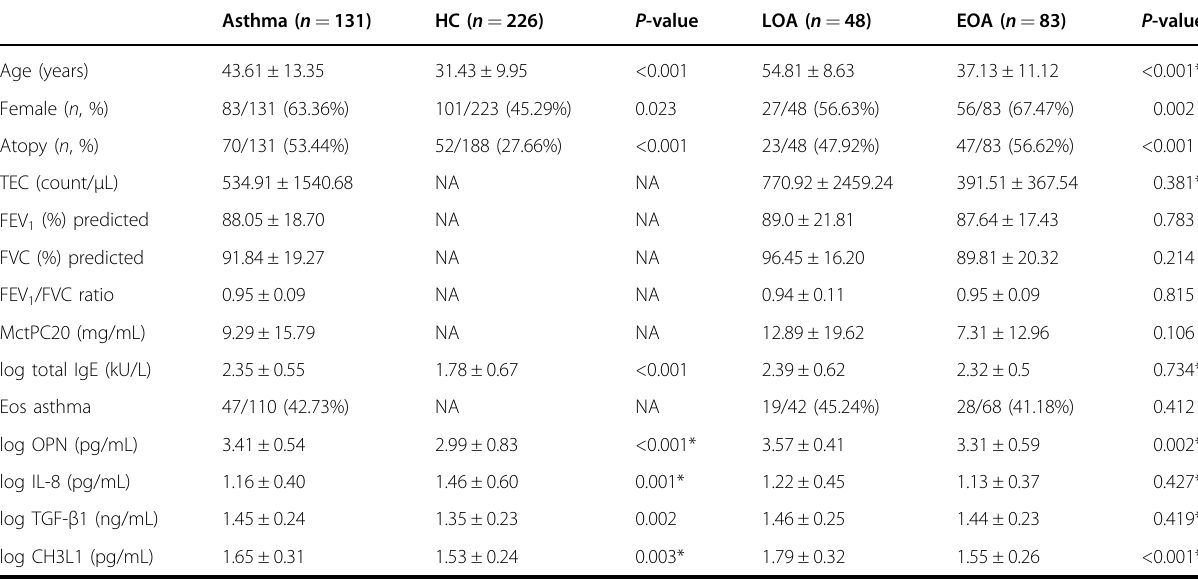
Table 1 Demographic characteristics and serum cytokine quanti fi